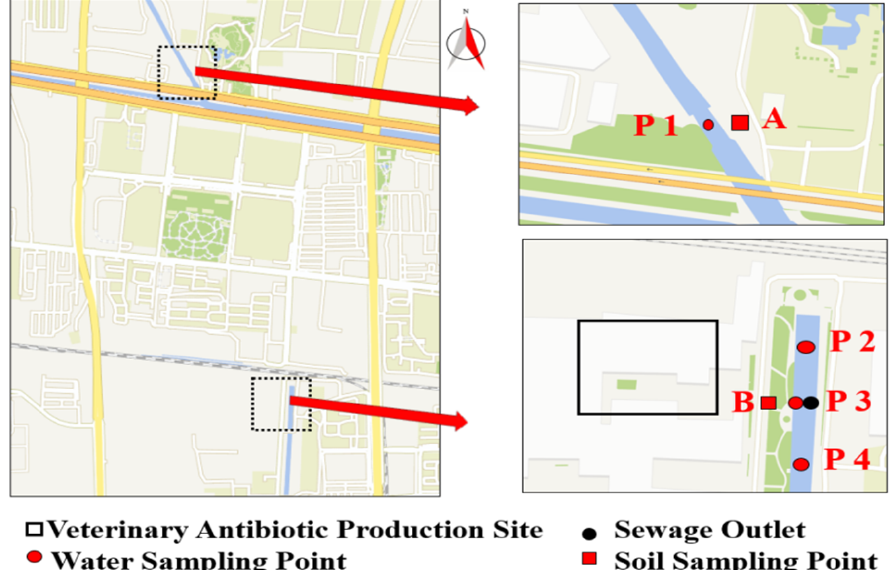
Figure 5. Geographical map of water and soil sampling sites.